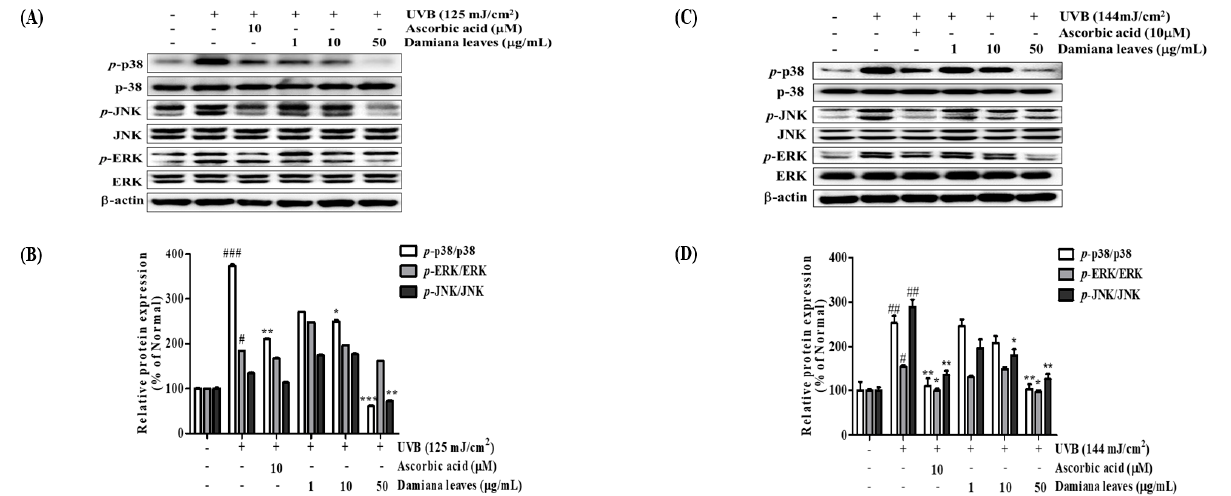
Figure 9. Effect of Damiana leaves extract on protein expression of phosphorylated MAPK signaling pathway on UVB-irradiated HaCaT ( A , B ) and HDF ( C , D ) cells. Data are presented as the mean ± SD. # and * indicate significant differences from the non-irradiated control and UVB-treated groups, respectively. # , ## and ### p < 0.05, 0.01 and 0.001 vs. the non-treated group. *, ** and *** p < 0.05, 0.01, and 0.001 vs. the UVB-treated control, respectively.